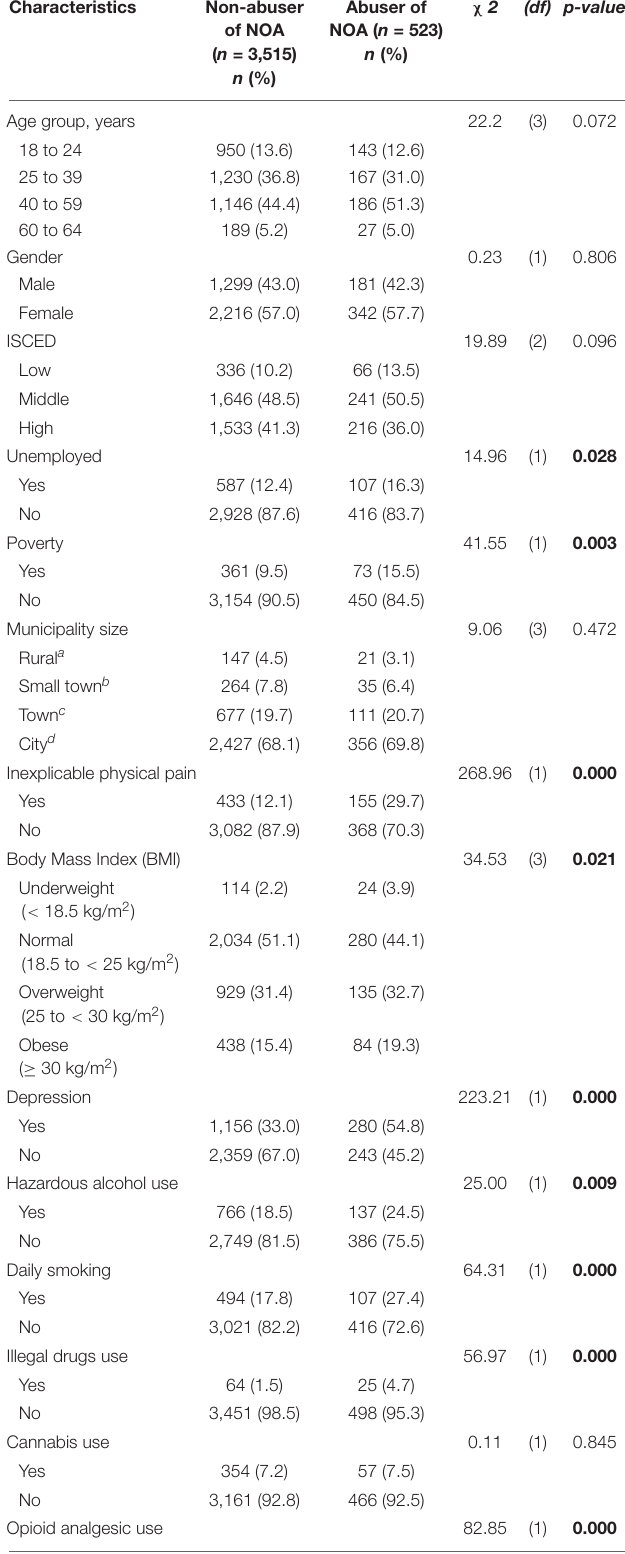
TABLE 2 | Sociodemographic- behavioral- and health-related characteristics of abuser and non-abuser of non-opioid analgesics (NOA).